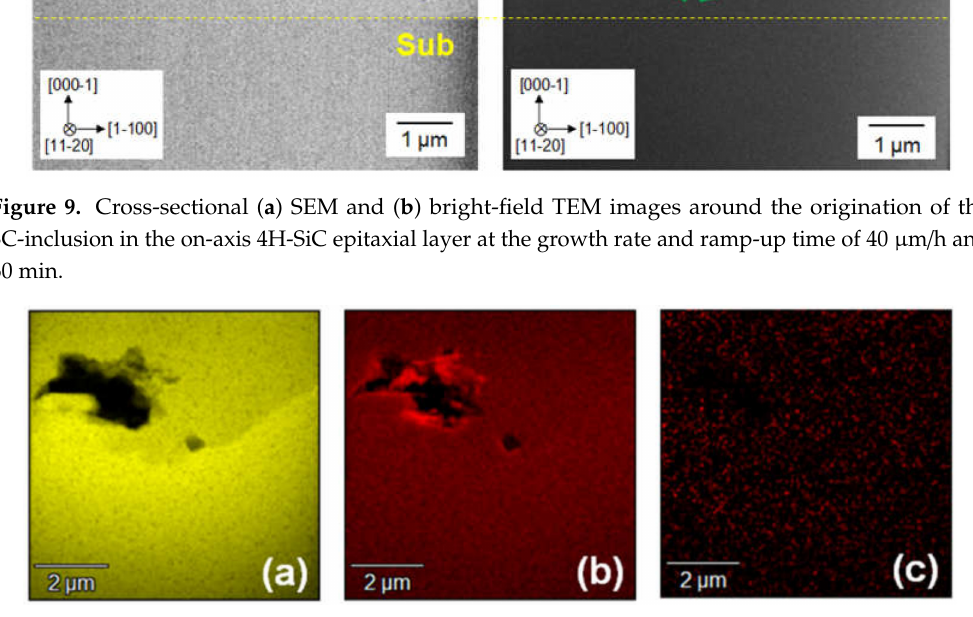
Figure 10. Energy-dispersive X-ray spectroscopy (EDX) maps of ( a ) Si, ( b ) C, and ( c ) Ta in the same area as that in Figure